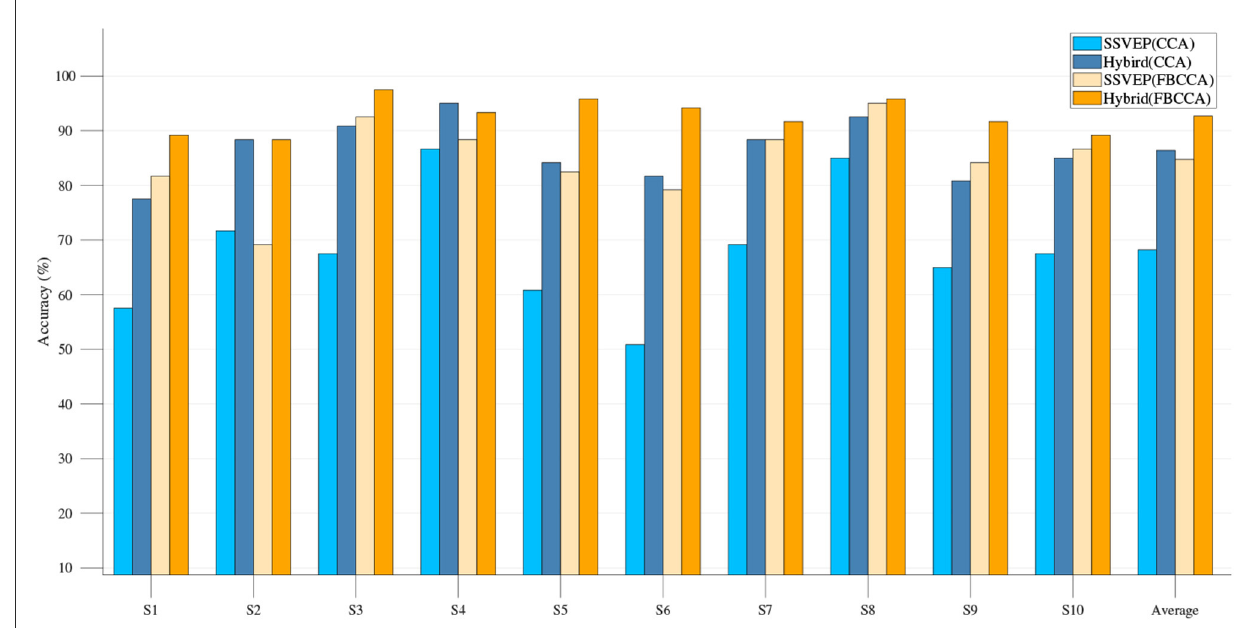
FIGURE10 Classification accuracy of single-modality SSVEP and hybrid BCI system based on CCA and FBCCA.